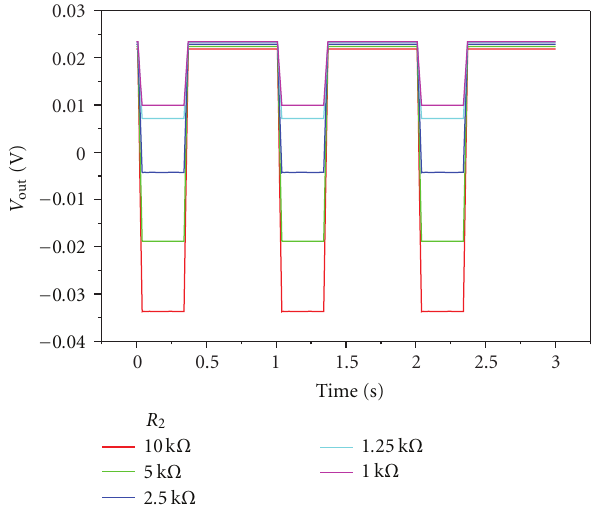
Figure 13: Output voltage levels for the pulse parameter for a change of the resistance of R 2 (1 (k Ω ) ∼ 10 (k Ω )).